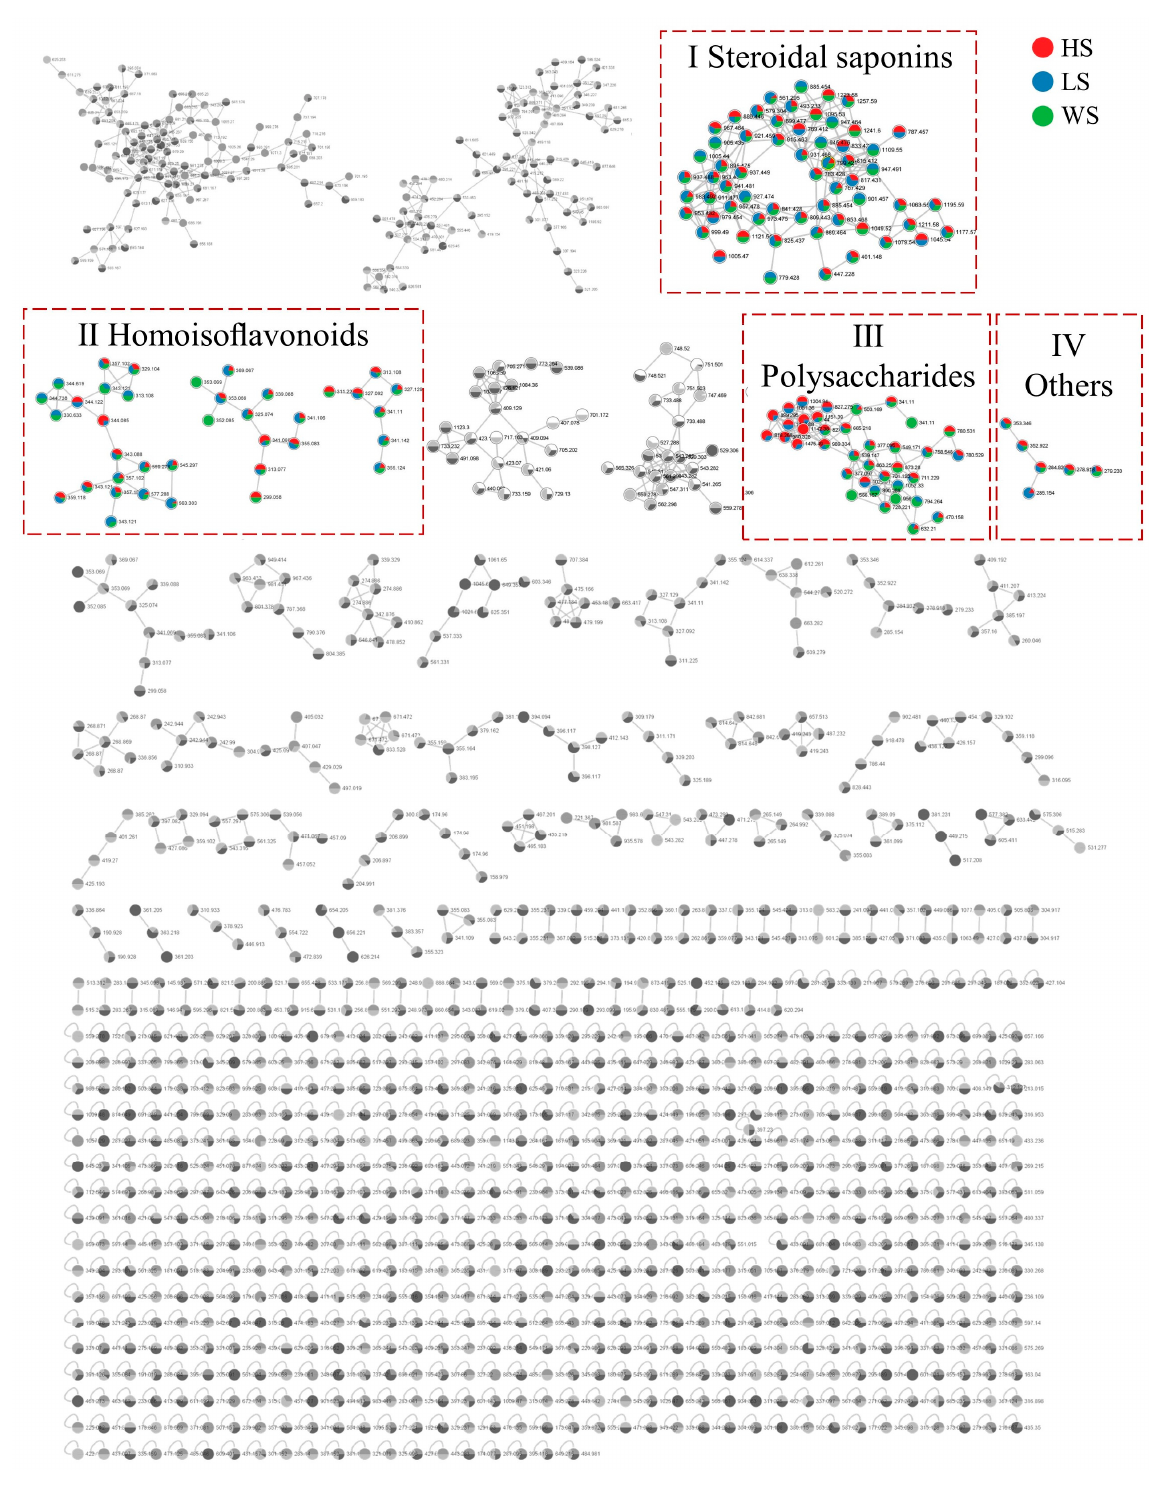
Figure 2. The molecular networks of MD with different levels of SF. (I) Steroidal saponins; (II) Homoisoflavonoids; (III) Polysaccharide; (IV) Others. HS: high concentration sulfur fumigation; LS: low concentration sulfur fumigation; WS: without sulfur fumigation.